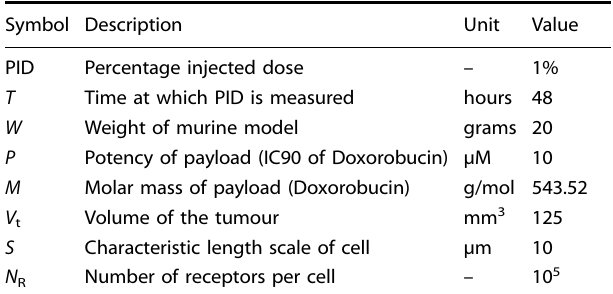
Table 1. Description and value of the assumed parameters for